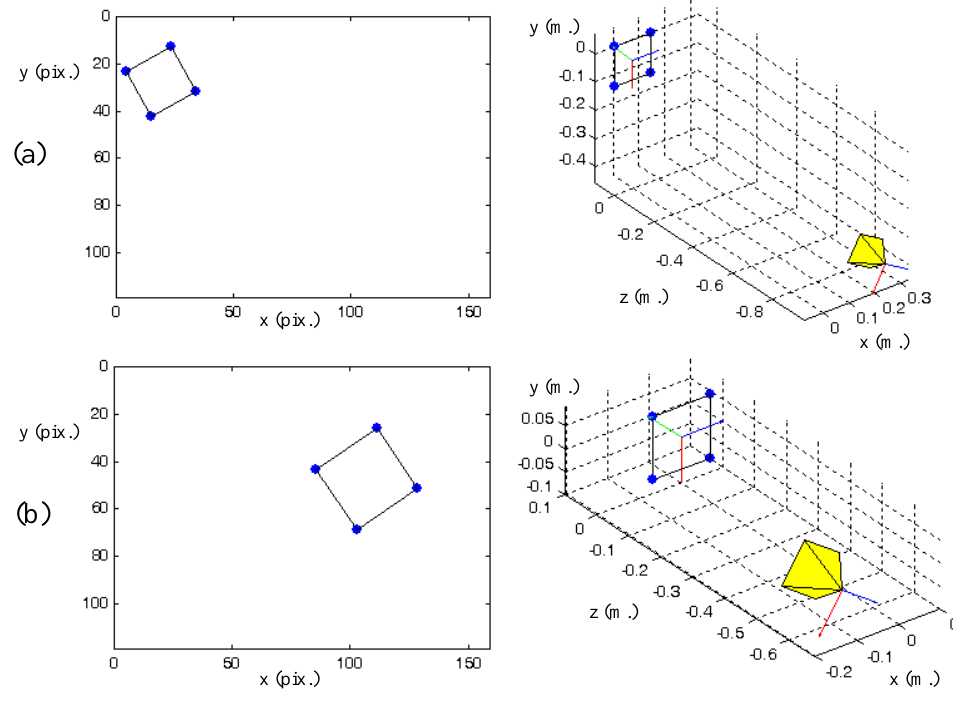
Figure 6. (a) Initial position of the image features and the eye-in-hand camera. (b) Final position of the image features and the eye-in-hand camera. (Trajectory 1).